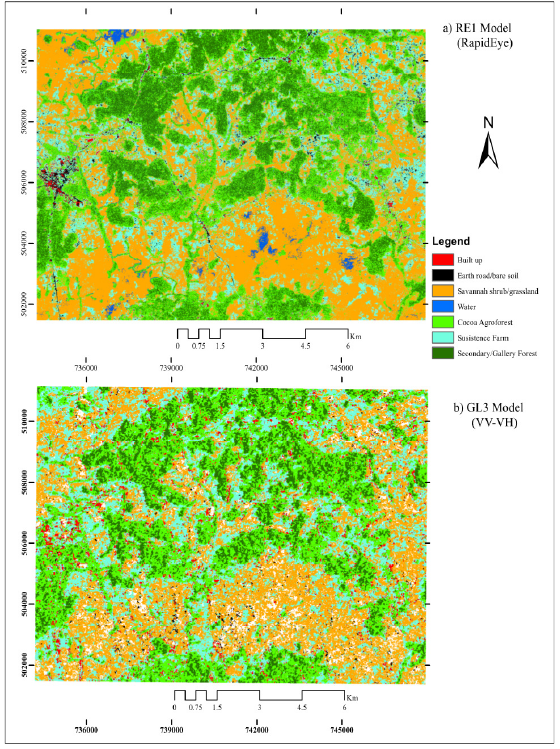
Figure 3. Thematic land cover maps from a) dry season multi- spectral optical image, and b) multi-seasonal SAR derived texture images (legend and north arrow apply to both images).